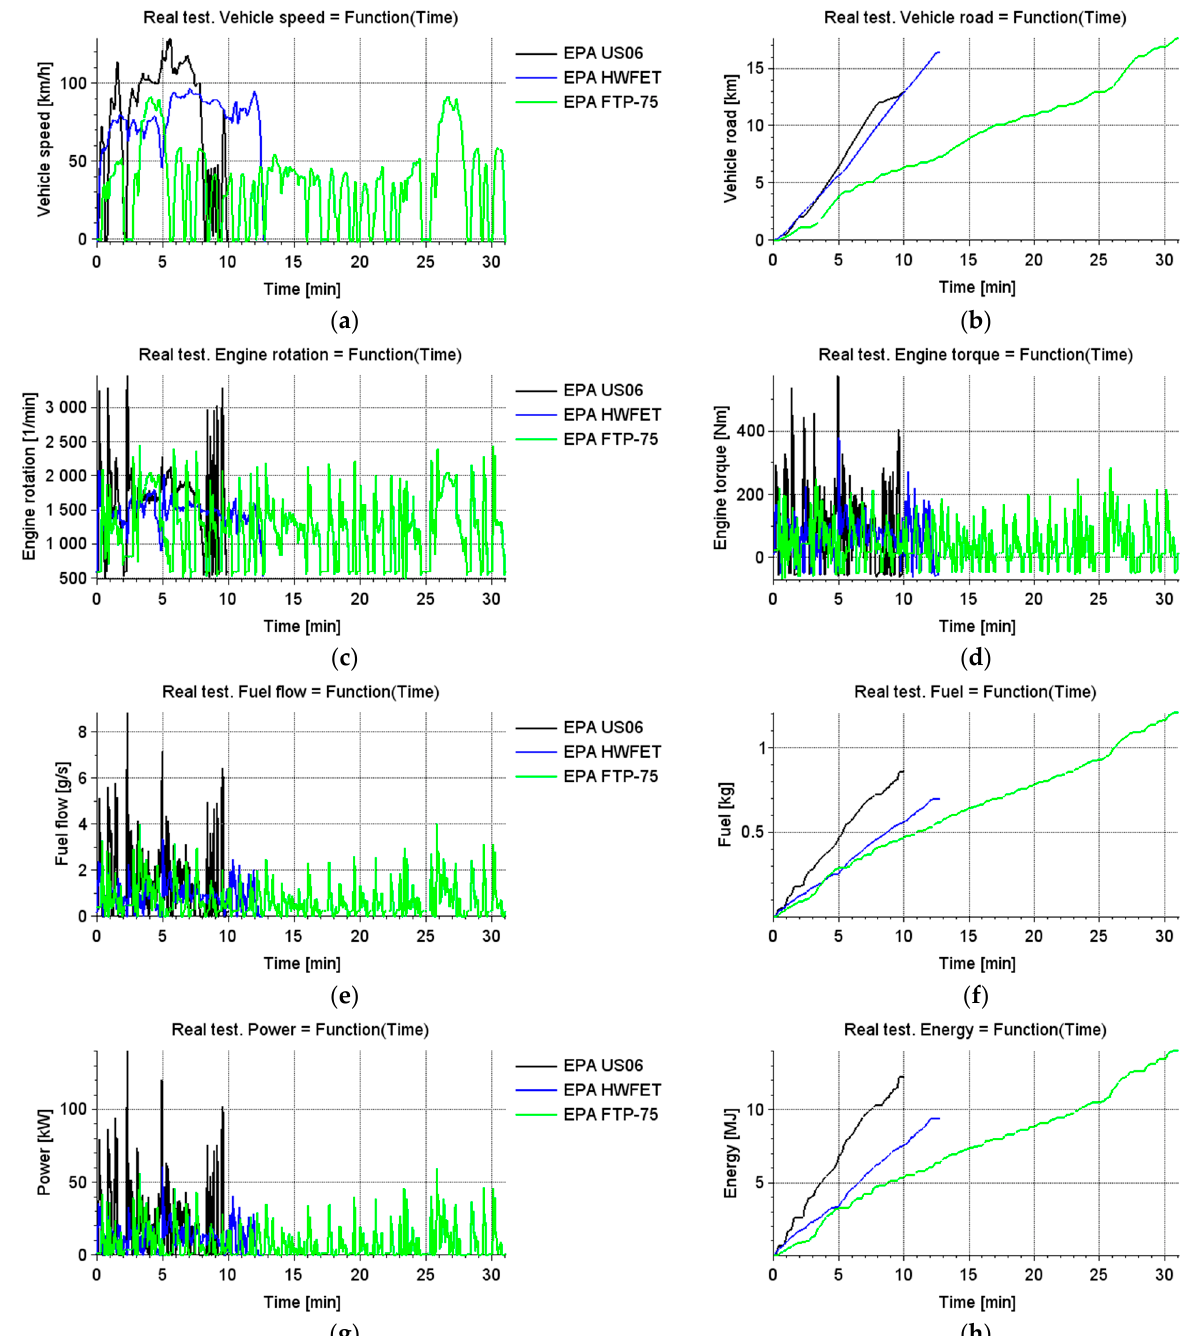
Figure 6. The results of the simulation work for the processed data from EPA tests for the Toyota Camry LE 2018 vehicle: ( a ) waveforms of the instantaneous vehicle speed values; ( b ) waveforms of the instantaneous values of the distance travelled by the vehicle; ( c ) waveforms of the instantaneous vehicle engine speed values; ( d ) waveforms of the instantaneous values of torque generated by the vehicle engine; ( e ) waveforms of the instantaneous values of the fuel stream powering the vehicle engine; ( f ) waveforms of the instantaneous fuel consumption values for the vehicle; ( g ) waveforms of the instantaneous values of power generated by the vehicle’s engine; ( h ) waveforms of the instantaneous values of mechanical energy generated by the vehicle engine.